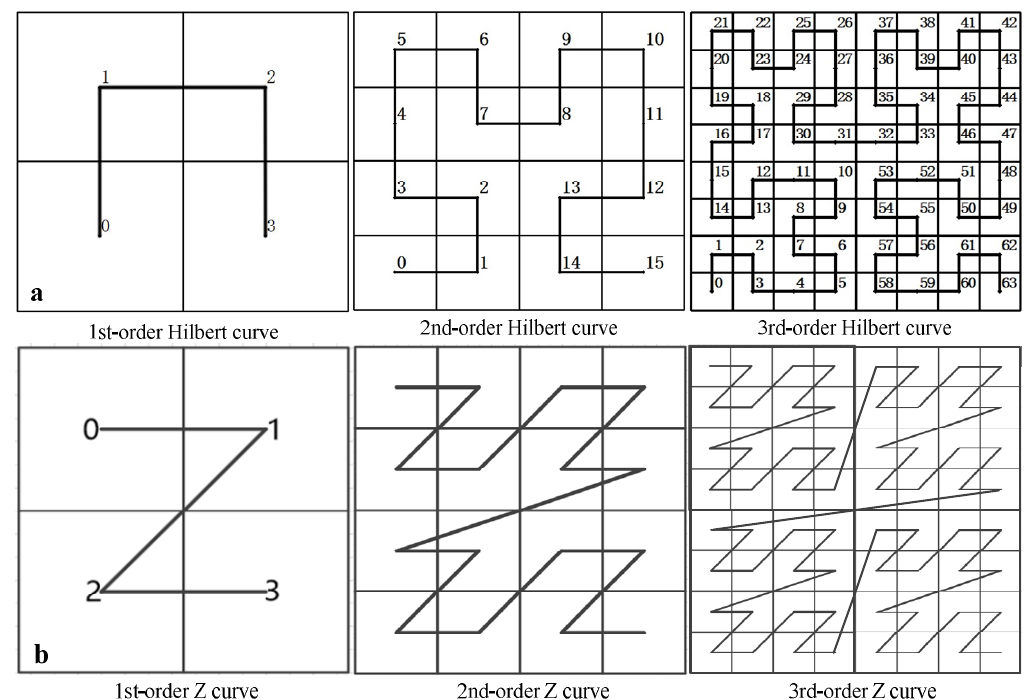
Figure 3. Space-filling curve schematic. ( a ) Coding principle of 1st, 2nd and 3rd order Hilbert curves, ( b ) Coding principle of 1st, 2nd and 3rd order Z-curves.